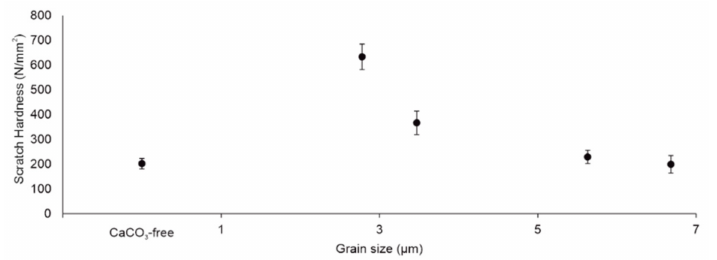
Figure 7. Scratch hardness versus grain size of CaCO 3 particles for scratch surfaces after the scratch